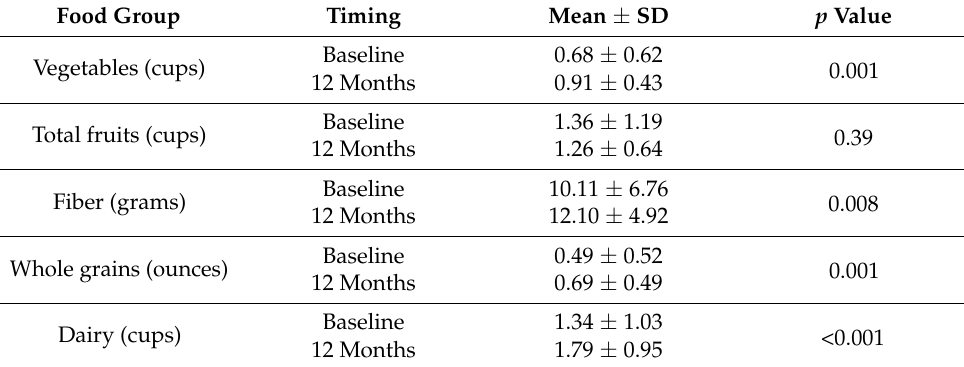
Table 2. Child-reported mean daily intake.